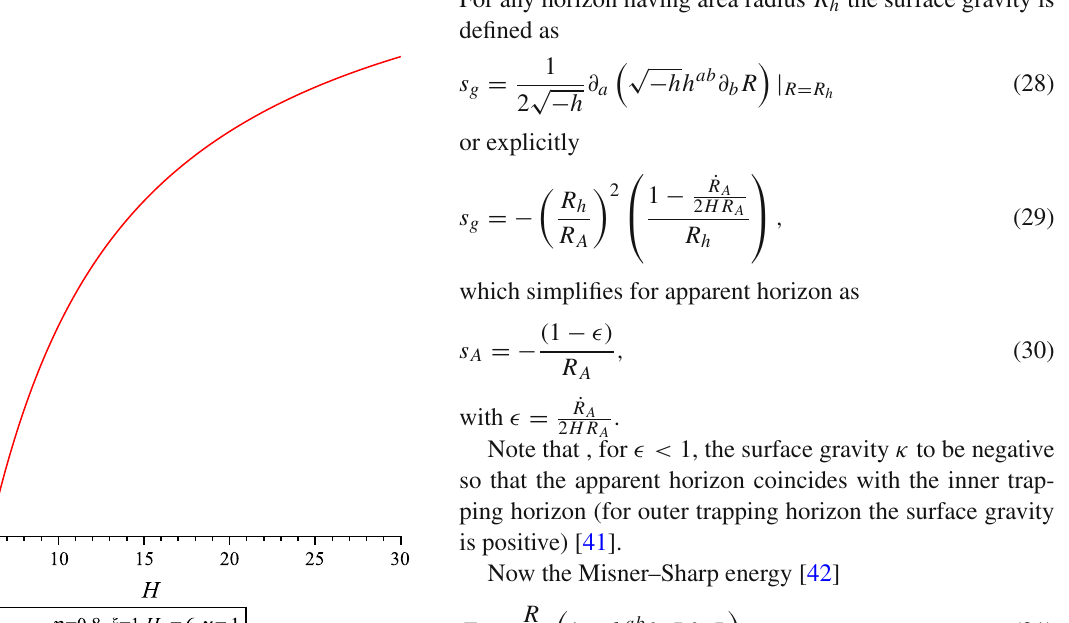
well as in modified gravity theories namely Lovelock gravity, scalar–tensor theory and Brane-World scenario [29,30,32]. Elling et al. [43] on the otherhand showed that Clausius rela- tion should be modified by introducing entropy production term in f ( R ) gravity theory. In the present work we shall modify the horizon entropy suitably so that Clausius relation is automatically satisfied for Rastall gravity theory (Figs. 1,